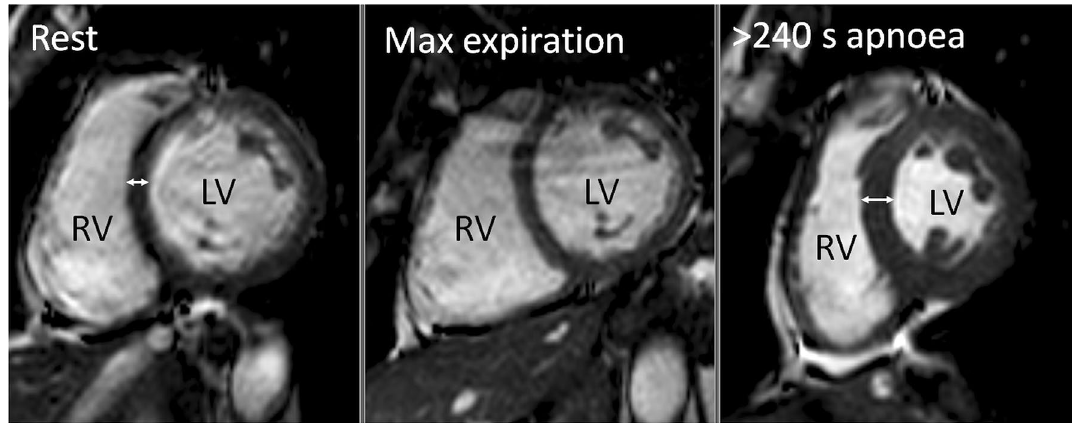
Figure 2. Example of Cardiac MR imaging of one subject, displaying a midventricular short axis view at papillary muscle level at end-diastole. Compared to rest (left panel), the left ventricle (LV) and right ventricle (RV) are similar in size at end of apnea with maximum expiration (center panel). In contrast, at the end of > 240 s of apnea with glossopharyngeal insufflation (right panel) there is a decrease in LV and RV size and thickening of the ventricular wall (double-headed arrows) compared to rest.